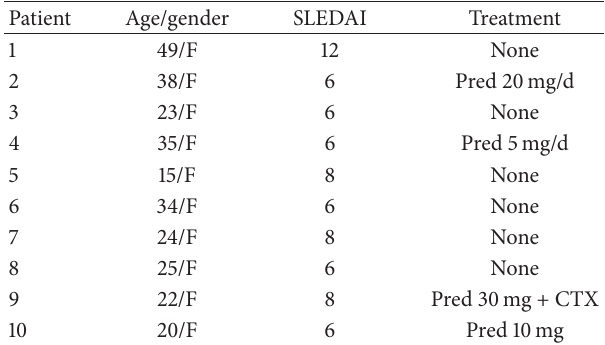
Figure 1: Representative gel showing protein bands immunopre- cipitated with anti-human Gadd45a antibody. Lane 1: prestained markers, lanes 3, 5, and 7: immunoprecipitated with anti-Gadd45a antibody, and lanes 2, 4, and 6: immunoprecipitated with isotype- matched control IgG.